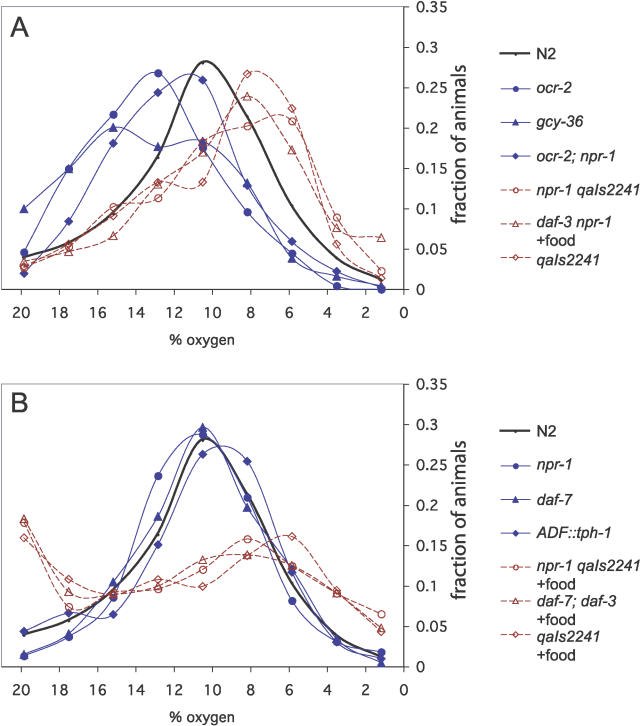
Second and Third Principal Components of Aerotaxis Data (PC2, PC3)(A) Assays with the highest (blue) and lowest (red) values for the second principal component (PC2), out of 36 sets of assays examined. Wild-type N2 animals off food are included for comparison (black, thick lines).(B) Assays with the highest (blue) and lowest (red) values for the third principal component (PC3), out of 36 sets of assays examined. Wild-type N2 animals off food are included for comparison (black, thick lines).